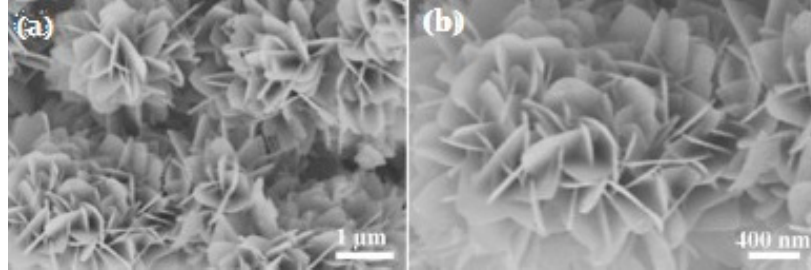
Figure 8. SEM images of ZnO nanoflowers with the resolution of ( a ) 1 μ m and ( b ) 400 nm [53].